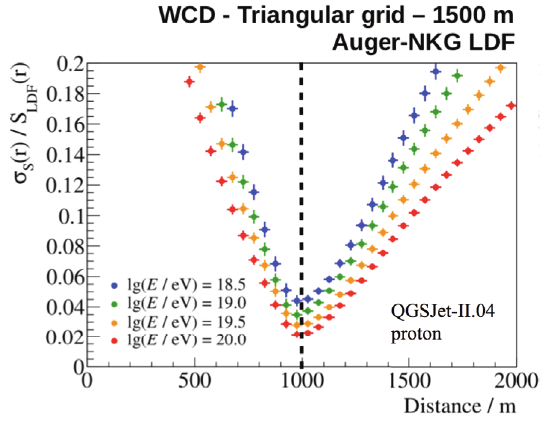
Figure 5. Fluctuations of the signal estimated with the Auger LDF arising from the uncertainty in the slope parameters.